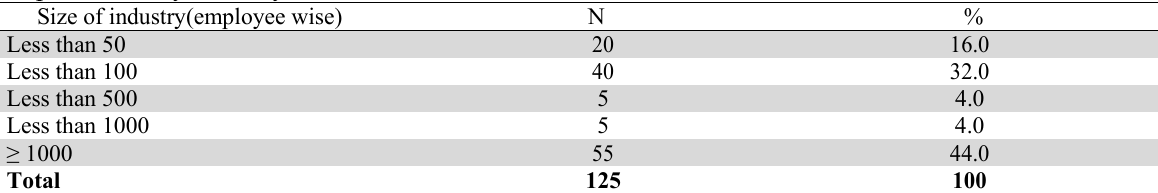
Response rate by industry size Size of industry(employee wise)